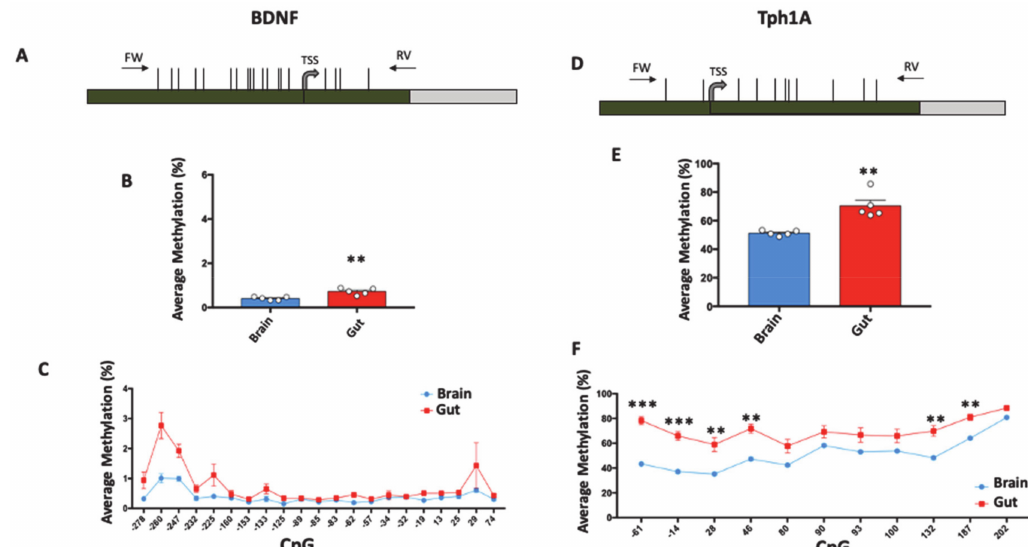
Figure 2. Tissue-specific DNA methylation of BDNF and Tph1A in gut and brain. ( A ) BDNF promoter region structure showing the position of analyzed CpGs (Horizontal black lines). The numbers of the CpG sites refer to the putative transcriptional start site (TSS), indicated with +1. Green box and gray box indicate promoter and the first intron, respectively. Positions of primers (FW: Forward; RV: Reverse) used for amplification procedure are reported. The BDNF sequence was retrieved by Ensembl with the following accession number: ENSDARG00000018817. ( B ) BDNF average methylation (%) in brain (Blue Box) and gut (Red Box) of untreated Zebrafishes is reported and indicated as the mean ± standard error of five samples. ( C ) Average methylation at single CpG site (%) at the BDNF promoter region in brain and gut is reported with blue and red lines, respectively, and indicated as the mean ± standard error of five samples. ( D ) Tph1A promoter region structure showing the position of the analyzed CpGs with numbers referring to the putative transcriptional start site (TSS). Green and gray boxes indicate promoter and the first intron, respectively. Black arrows at the top of the map specify the position of the primers used for bisulfite amplification. The Tph1A sequence was retrieved by Ensembl with the following accession number: ENSDARG00000029432. ( E ) Average methylation (%) at Tph1A in gut and brain of five control Zebrafishes . ( F ) Methylation level at single-CpG sites (%) in the Tph1A analyzed region. Comparison between brain and gut for both Tph1A and BDNF was performed using Student t -test (** p ≤ 0.01) . Statistical analyses at single-CpG levels were performed using one-way ANOVA followed by Tukey’s multiple comparison post-hoc test (* p ≤ 0.05; ** p ≤ 0.01; *** p ≤